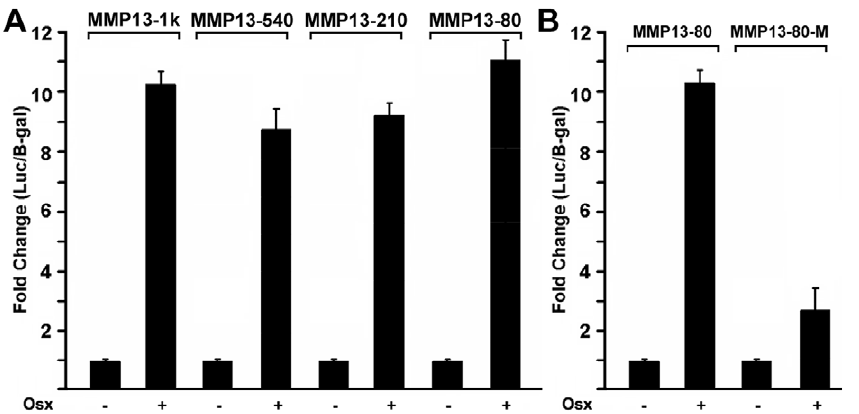
Figure 5. Identification of the Osx binding site in the promoter of MMP13 gene. (A) Deletion analysis of the MMP13 promoter-reporter constructs. MMP13-1 kb, MMP13-540 bp, MMP13-210 bp and MMP13-80 bp promoter-reporter plasmids (300 ng each) were cotransfected with 400 ng of the Osx expression plasmid in HEK293 cells. Twenty-four hours post-transfection, cell extracts were prepared and analyzed for luciferase activity and normalized to b -galactosidase activity. (B) The GC-rich element in MMP13-80 is responsible for MMP13 promoter reporter activation by Osx. The promoter mutant MMP13-80-M was transfected into HEK293 cells and analyzed as described in panel A. Luciferase activity was normalized by b -galactosidase activity.